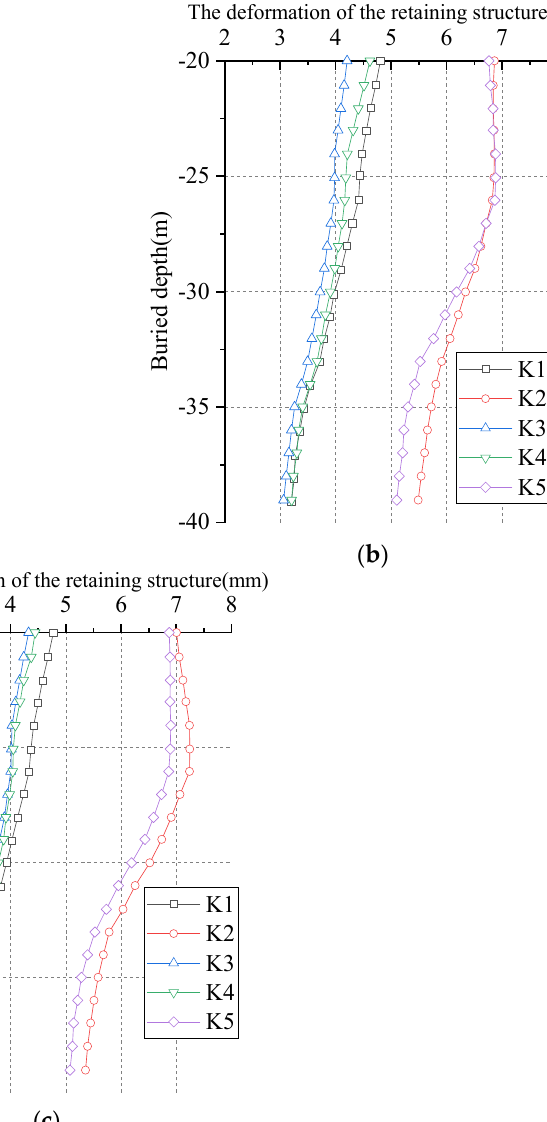
Figure 12. Deformation of the exterior retaining structure. ( a ) working Condition 1. ( b ) working Condition 2. ( c ) working Condition 3.